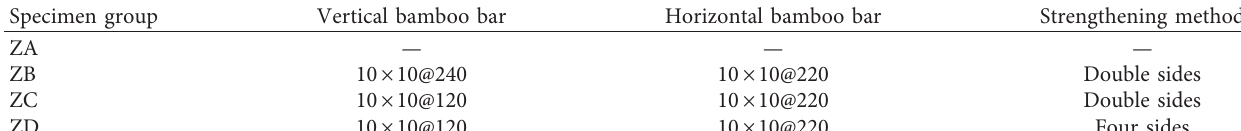
Table 1: Parameters of specimens.